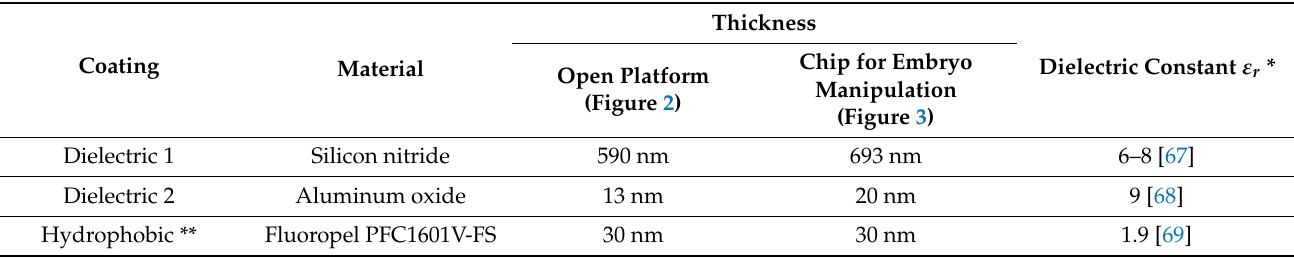
Table 1. Thicknesses and dielectric constants for the different dielectric and hydrophobic layers of materials used for EWOD devices.